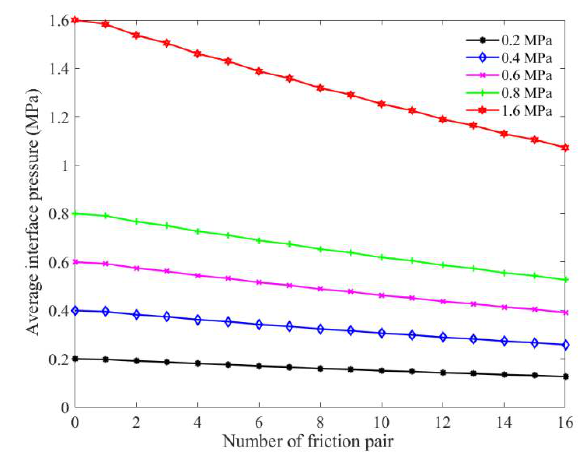
Figure 7. Attenuation of the contact pressure.